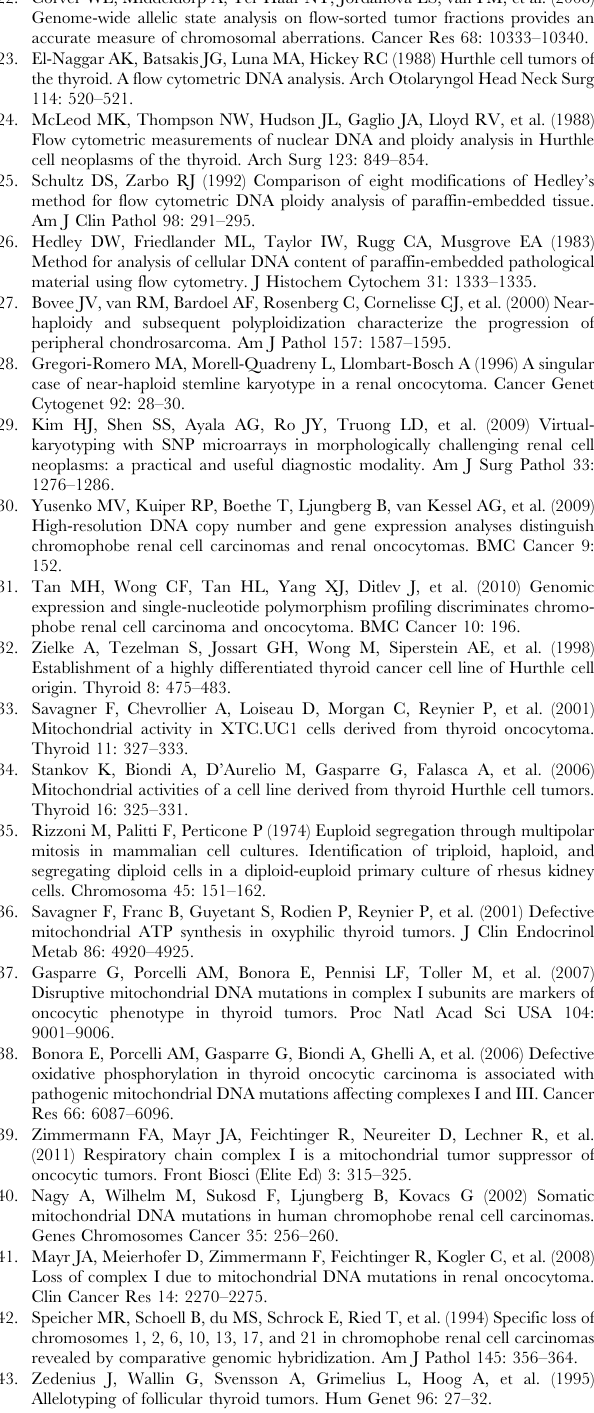
Figure S2 Summary of high-density genomic patterns found in the validation cohort (n=